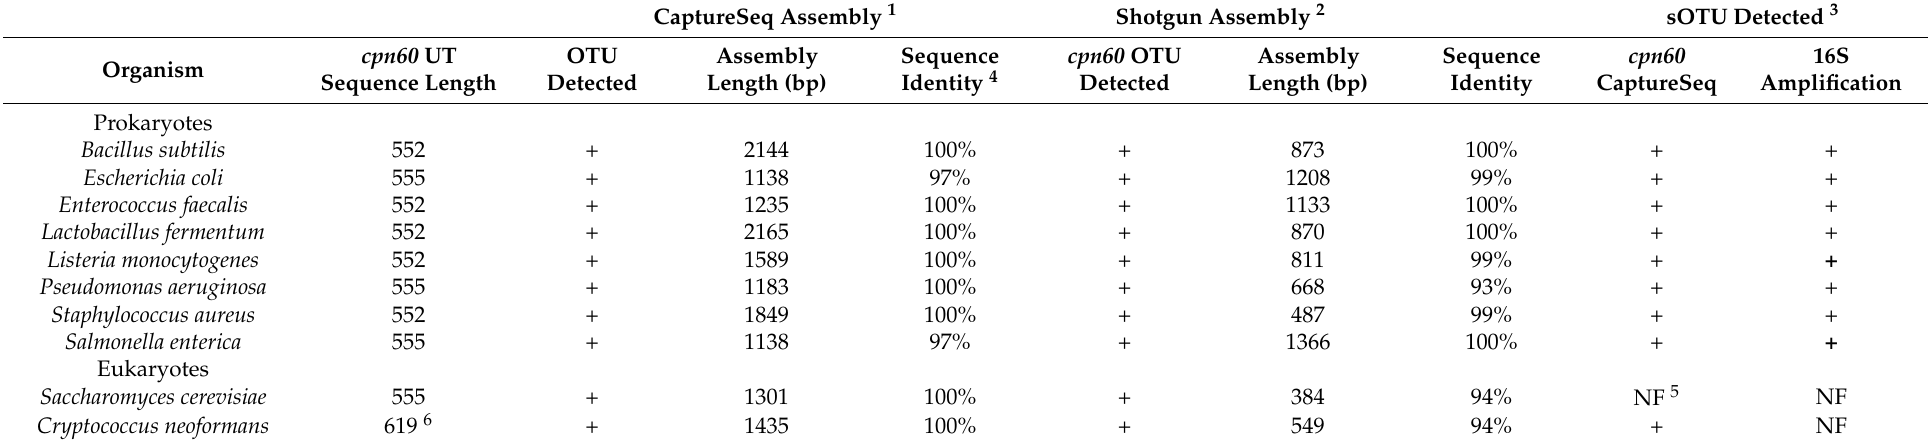
Table 1. Analysis of Zymobiomics microbial community DNA standard using cpn60 -based CaptureSeq, shotgun sequencing, and taxonomic marker gene amplification.